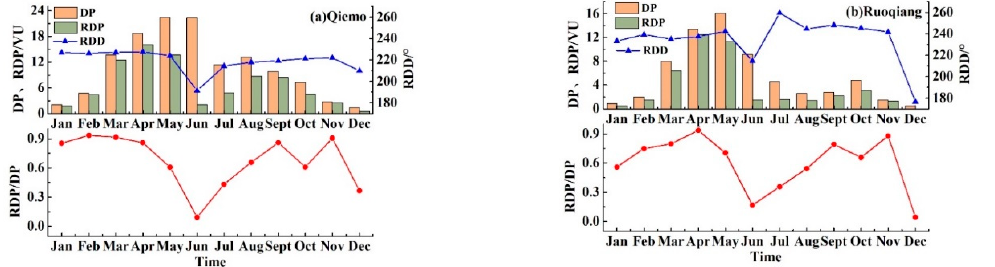
Figure 9. Characteristics of monthly DP: ( a ) Qiemo; ( b ) Ruoqiang.